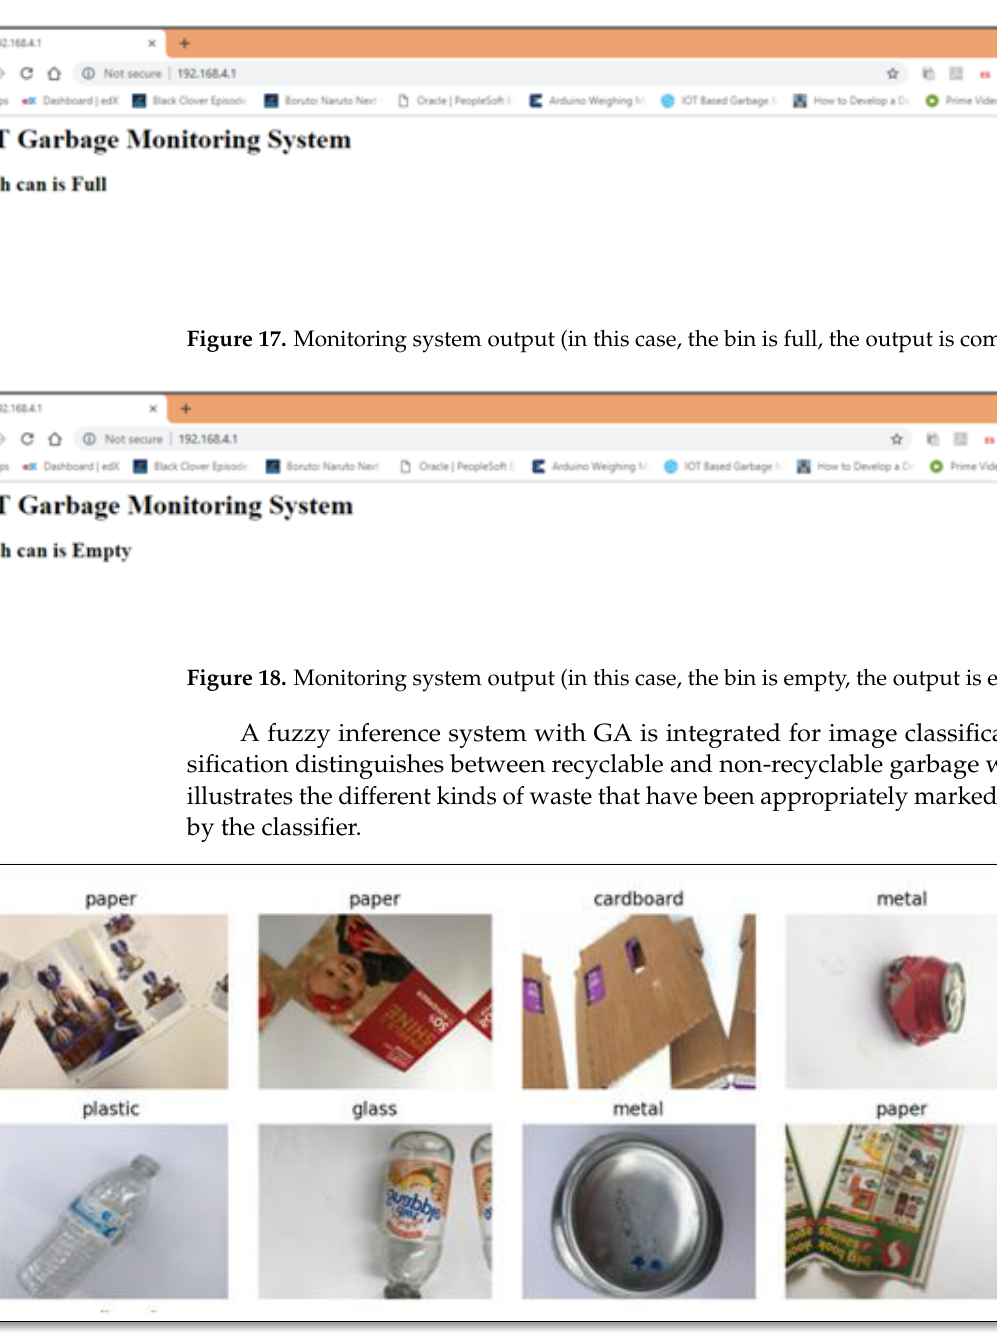
Figure 16. Weight detection for waste segregation.